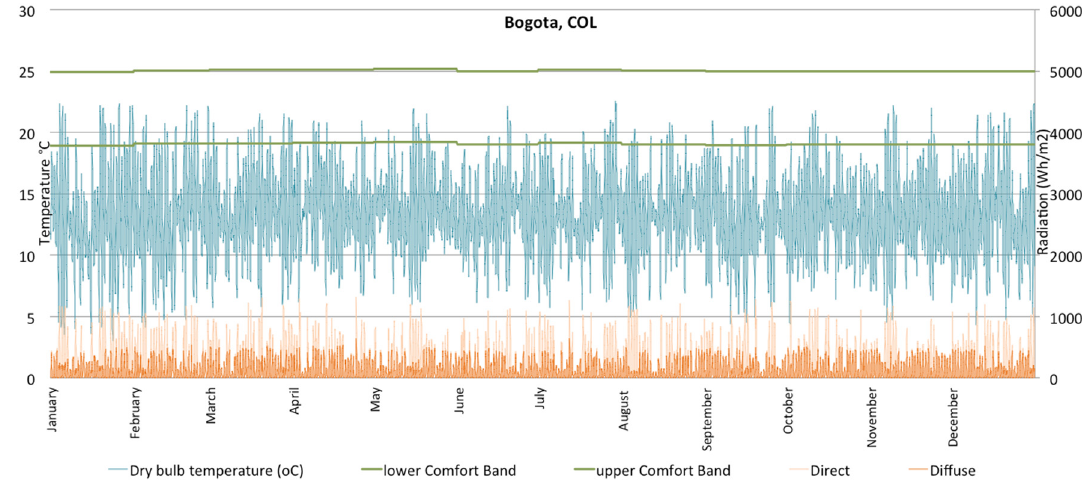
Figure 13. Hourly temperatures and comfort band for the city of Bogotá, adapted from ASHRAE 55.